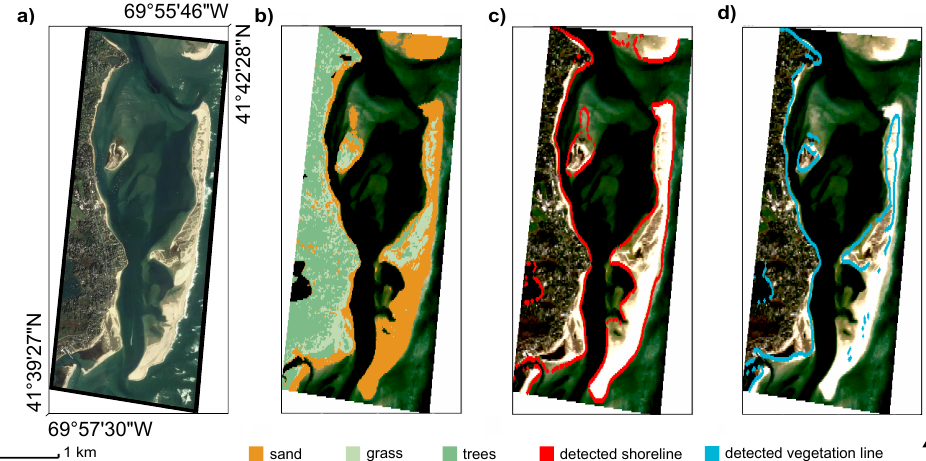
Figure 3. An example of the algorithm’s output: ( a ) view of the area of interest (Google Earth, 2021); ( b ) classified map of sand (orange), grassy vegetation (light green), and trees (dark green); ( c ) locally detected shorelines (in red), and ( d ) the vegetation–sand interfaces (cyan) (EPSG: